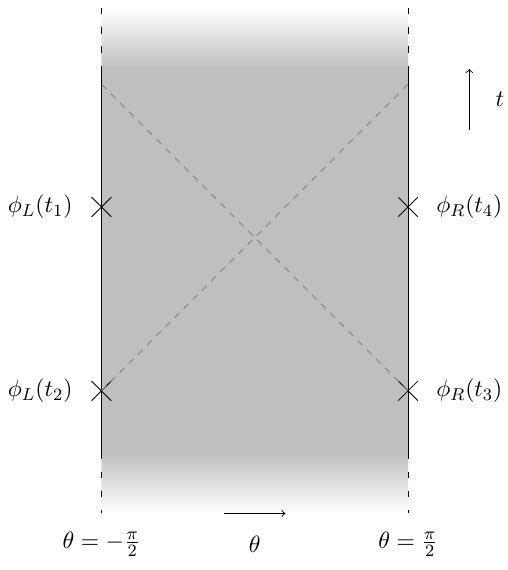
Figure 4 . Kinematics in which we define the double commutator on the boundary of AdS 2